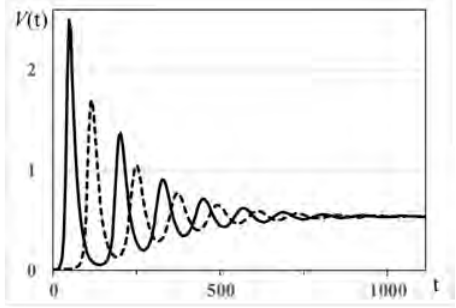
Fig. 17. of V ( t ) for oscillating dynamics for 2 different initial values ϕ ( a )